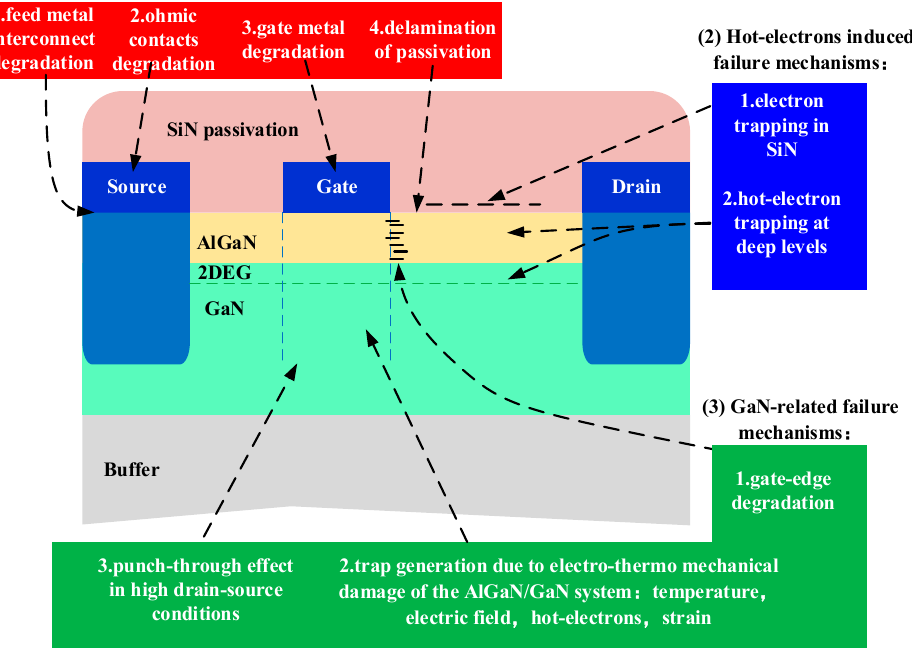
Figure 7. Schematic figure representing the mechanisms that can affect the reliability of High-Elec- tron-Mobility Transistors based on GaN [61]. Mobility Transistors based on GaN